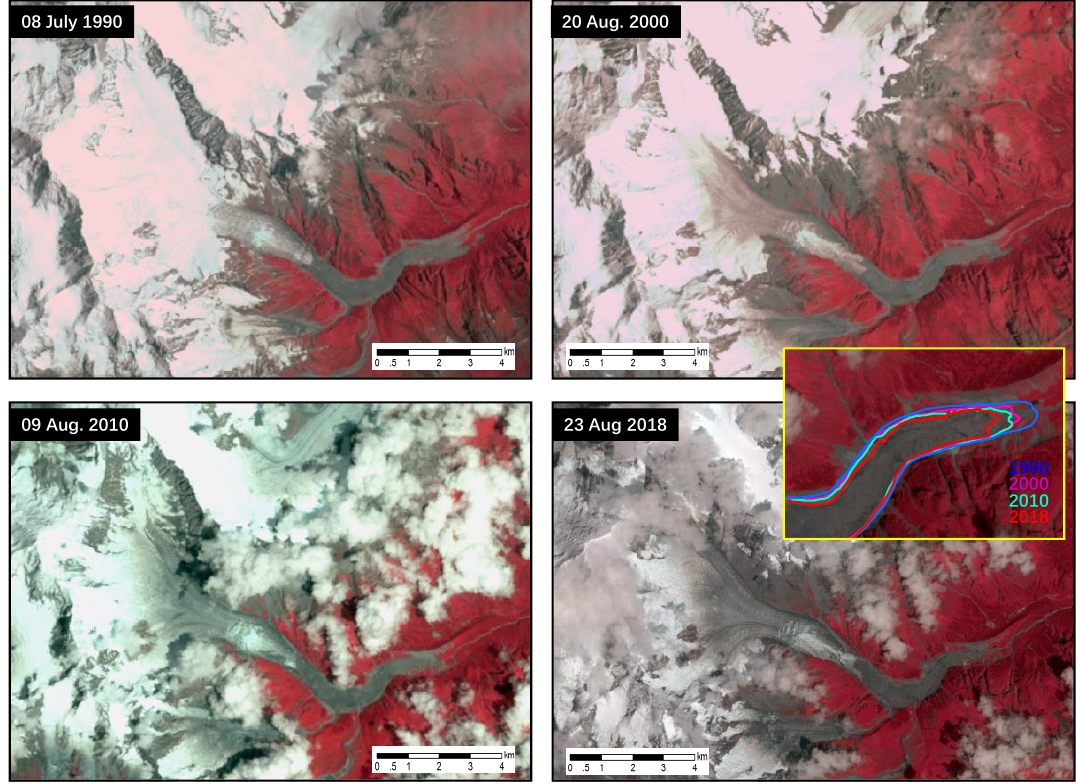
Figure 10. Repeated summer satellite images between 1990 and 2018. Note the retreating debris-covered ice tongue of the Hailuogou glacier and increasing summer darkened area of the ice fall and the upper accumulation areas (showing the false color composites of TM for 1990, 2000, and 2010, and the false color composite of Sentinel-2 for 2018). Remote Sens. 2020 , 12 , x FOR PEER REVIEW